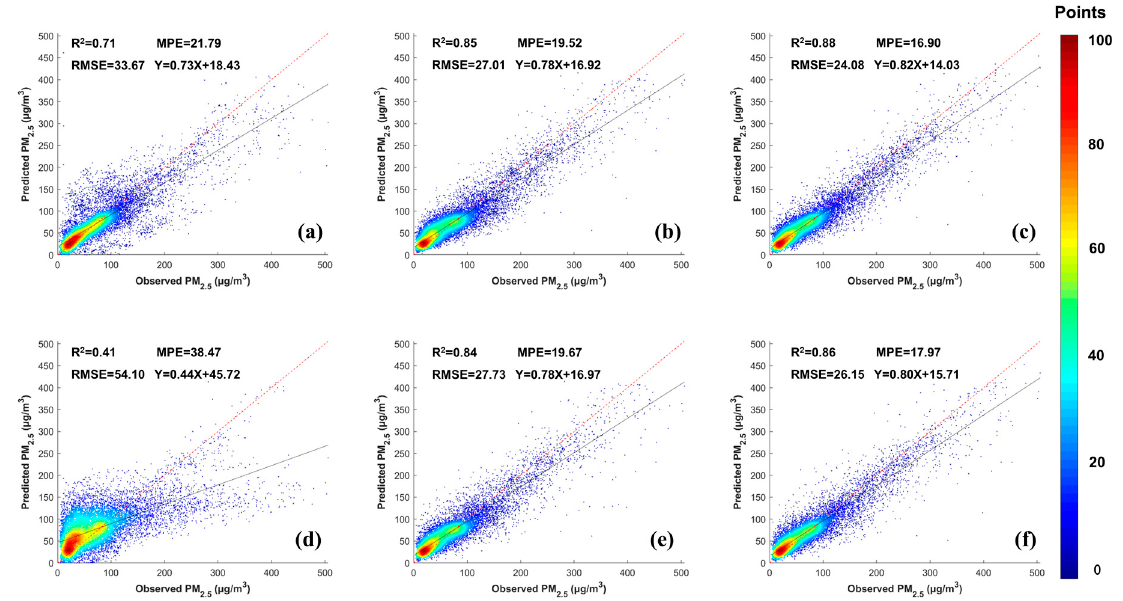
Figure 4. The density scattering plots of CV results. Sample-based result: ( a ) GWR, ( b ) XGBoost and ( c ) SL-XGB. Site-based result: ( d ) GWR, ( e ) XGBoost and ( f ) SL-XGB. The red lines represent the 1:1 lines and the black lines represent the fitting lines.